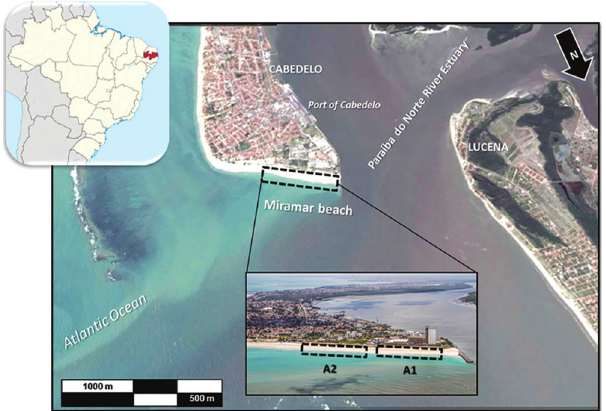
Fig. 1. Miramar beach in Cabedelo, Paraíba, northeast of Brazil. Two areas were highlighted (named as A1 and A2), located close to Paraíba River mouth (Source: Google Earth, accessed on 08 June